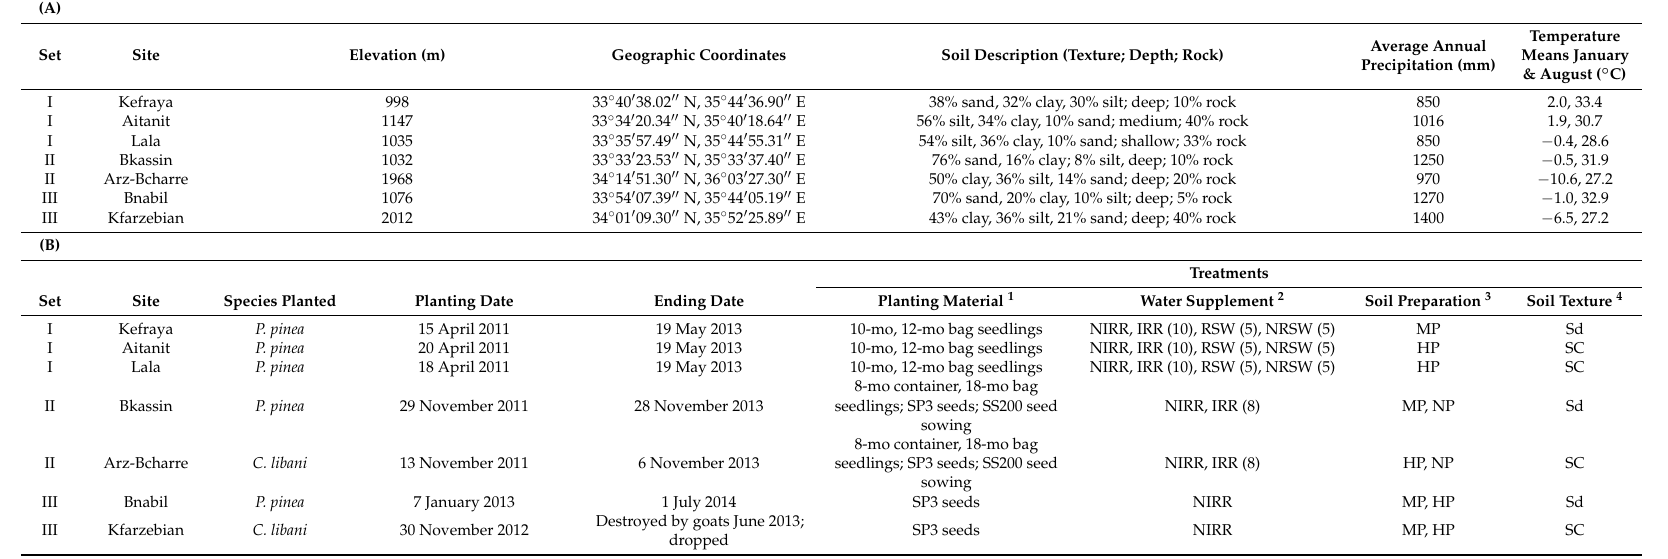
Table 1. Background information for Lebanon planting trials of stone pine ( Pinus pinea ) and Lebanon cedar ( Cedrus libani ) at 7 sites: ( A ) site characteristics; ( B ) planting and treatments.